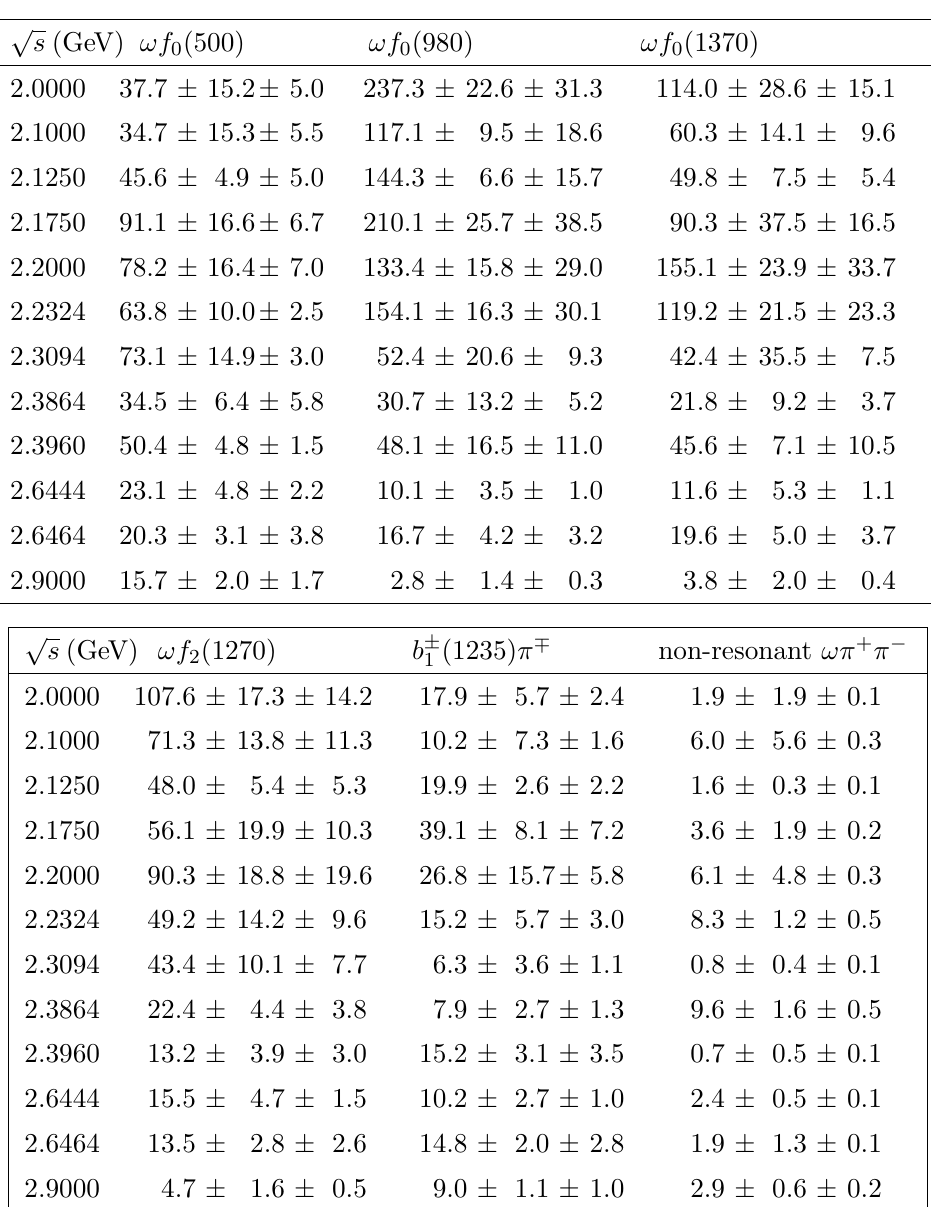
Table 5 . Born cross sections for the subprocesses at various selected energy points in unit of pb, where the first and second uncertainties are statistical and systematic,